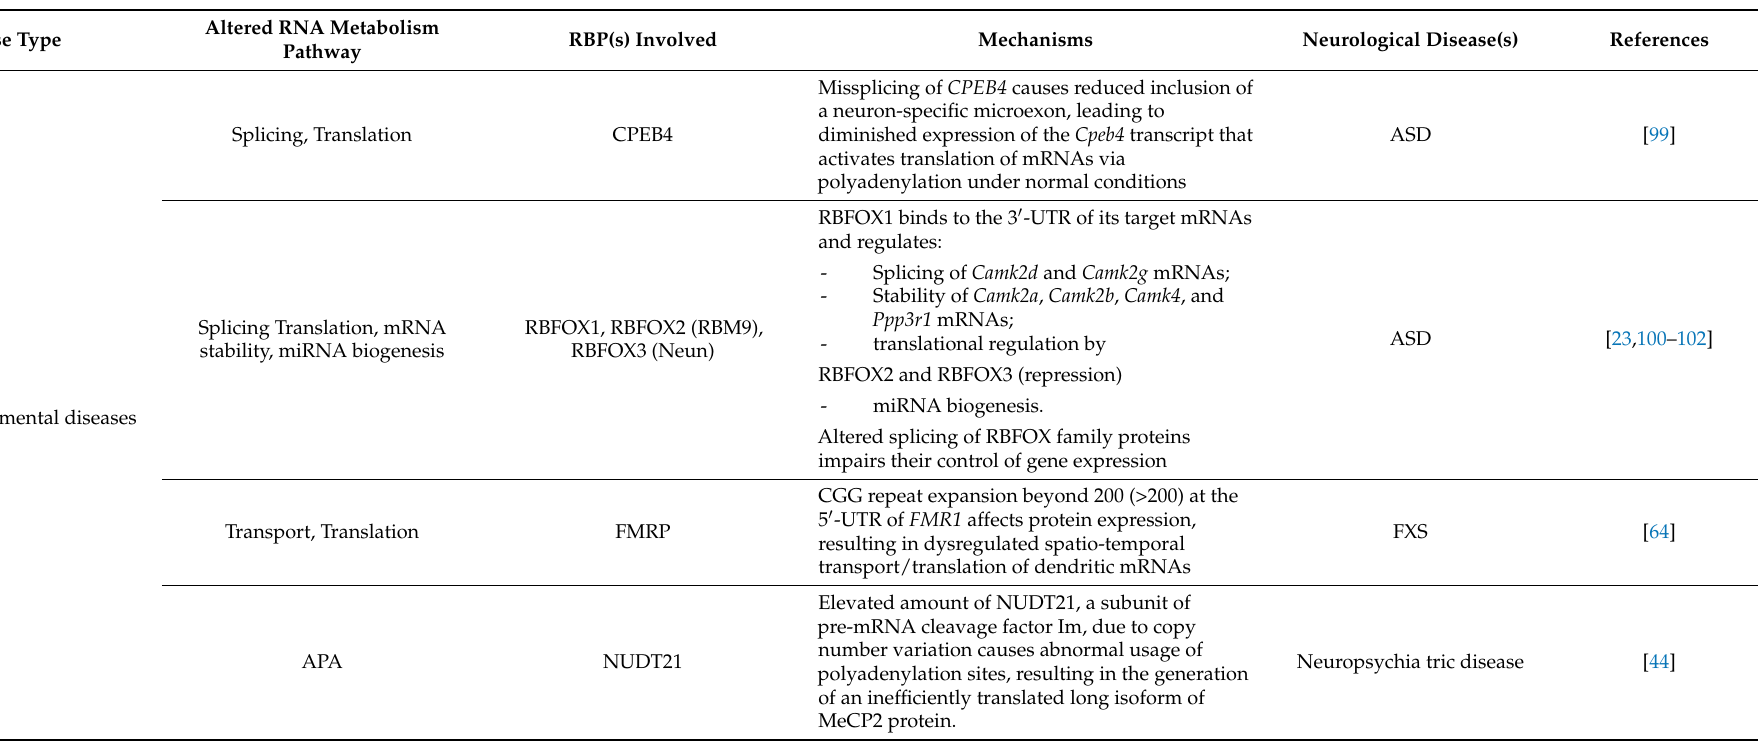
Table 1. Dysregulated RNA metabolism in neurological